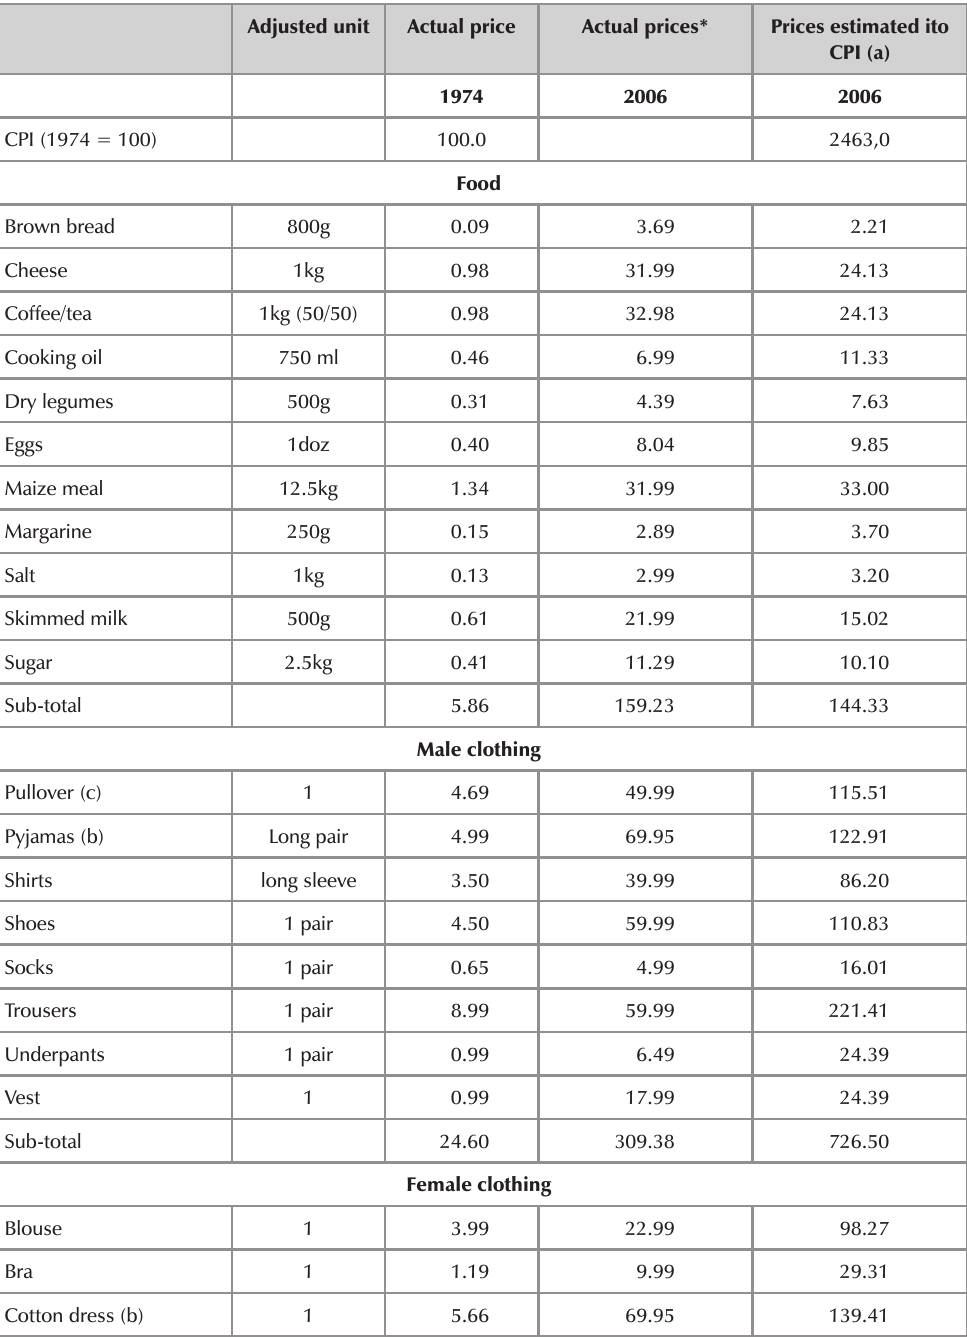
Comparison of actual and estimated prices of selected goods, 1974 to 2006 (all prices in